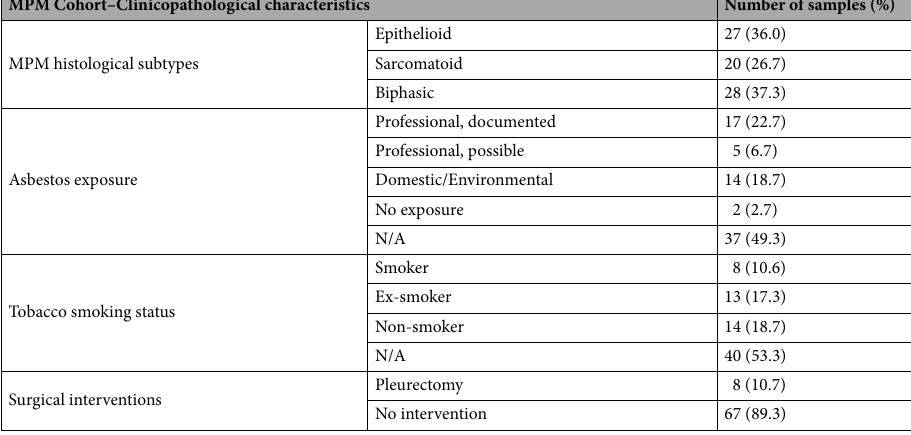
Table 1. Clinicopathological characteristics of MPM cohort. Clinicopathological characteristics, occupational e non-occupational information, collected for MPM cohort. It was not possible to obtain all information for all subjects (N/A: data not